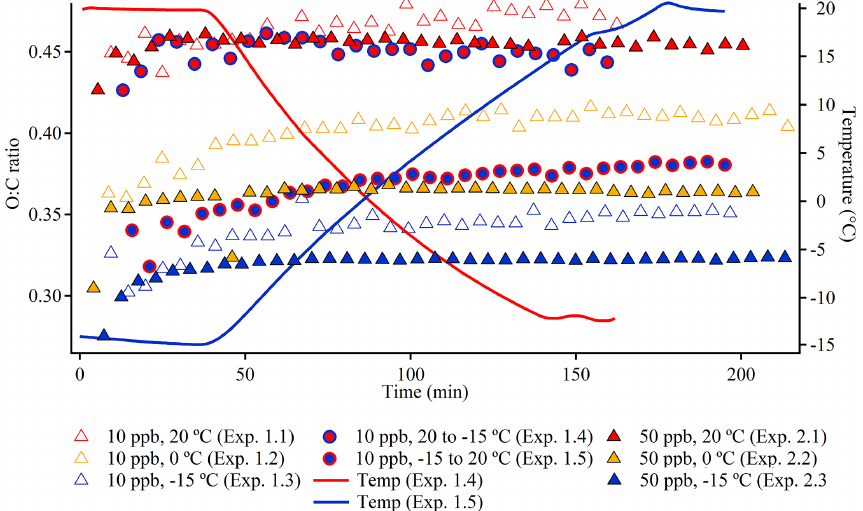
Figure 4. Time series of the O : C ratio in 10ppb α -pinene experiments (1.1–1.5) and 50ppb α -pinene experiments (2.1–2.3). Every fifth data point is shown. Standard errors are shown in Fig.